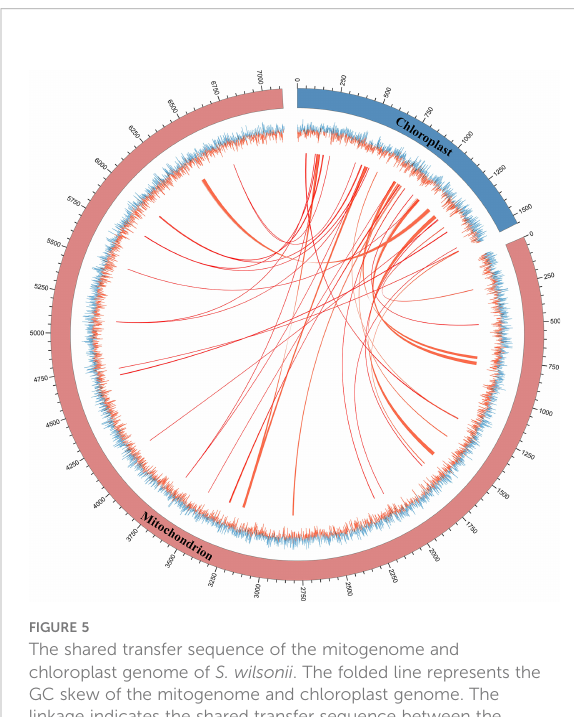
FIGURE 5 The shared transfer sequence of the mitogenome and chloroplast genome of S. wilsonii . The folded line represents the GC skew of the mitogenome and chloroplast genome. The linkage indicates the shared transfer sequence between the mitogenome and the chloroplast genome.